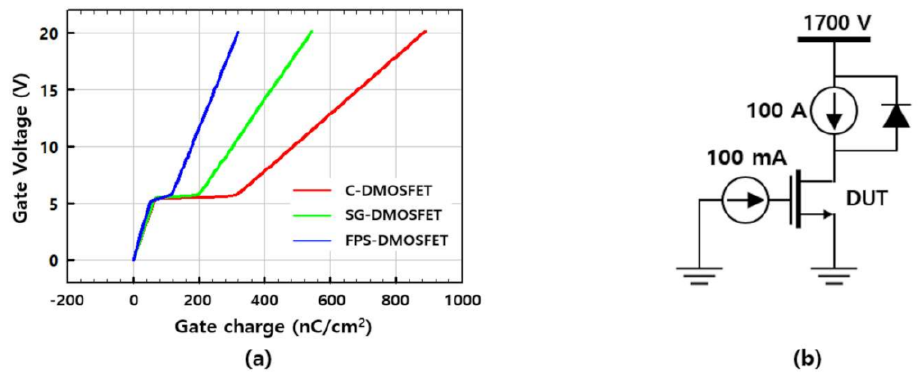
Figure 13. ( a ) Gate Charge curves of three structures and ( b ) the test circuit for gate charge